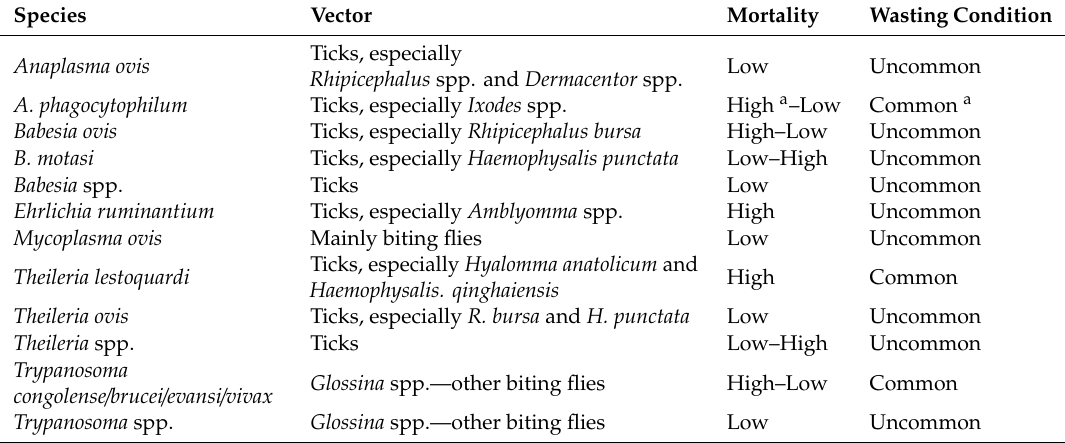
Table 1. Occurrence of mortality and wasting condition among haemoparasites in small